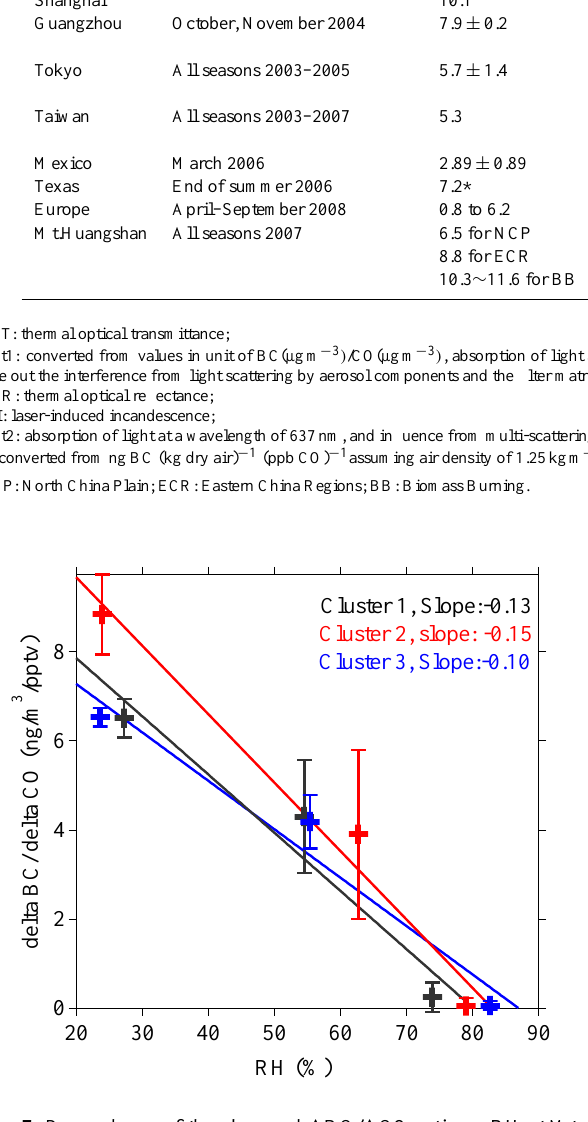
Fig. 7. Dependence of the observed 1 BC/ 1 CO ratio on RH at Mt. Huang for all non-rain periods. Relationships between 1 BC/ 1 CO and RH are fitted by linear regression method. The black, red and blue lines represent for Cluster #1, Cluster #2 and Cluster #3, re-